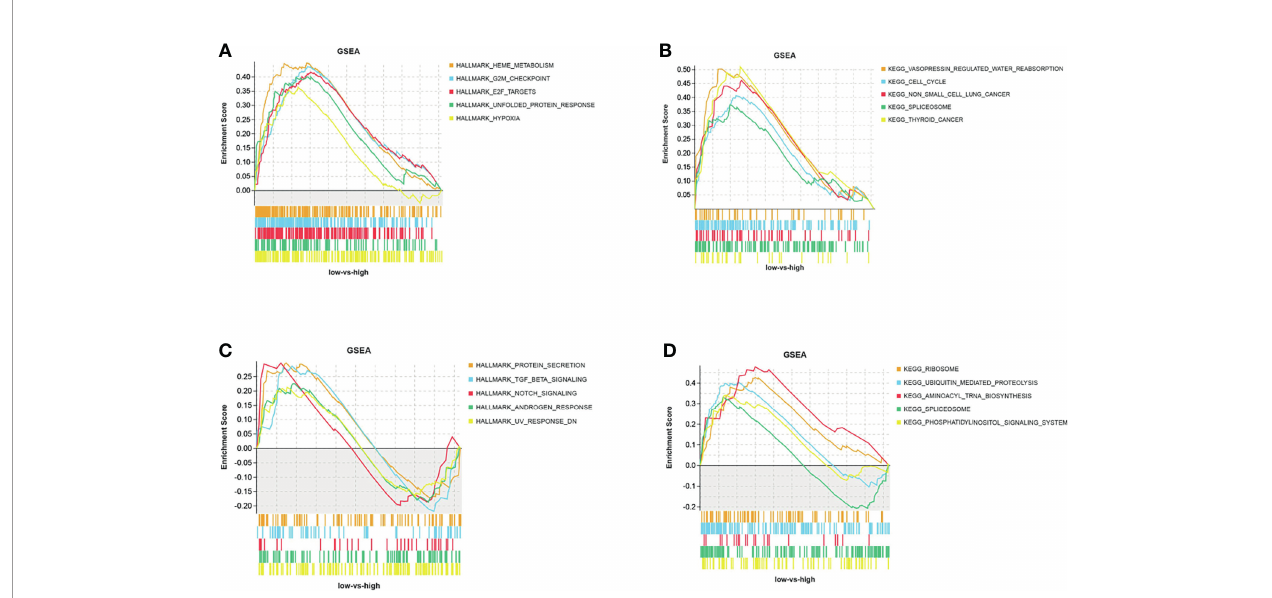
FIGURE 5 | GSEA analysis of CD47 Hallmark and KEGG pathways. (A) Hallmark and (B) KEGG pathways of CD47 in MDS tissues from the GSE30195 dataset, and (C) hallmark and (D) KEGG pathways of CD47 in AML tissues from the GSE30029 dataset.